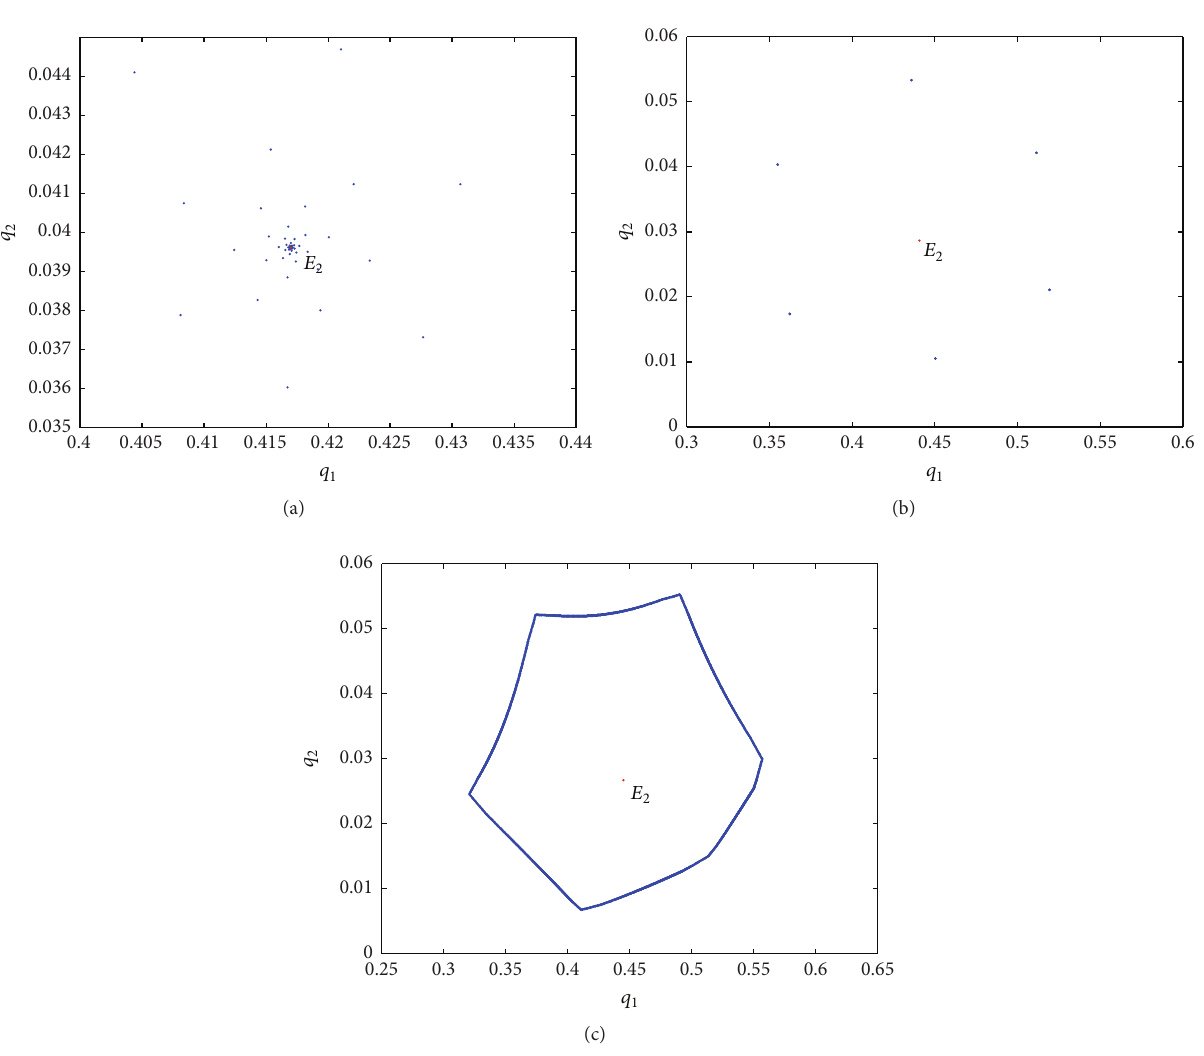
= 0.5, V = 0.5, 𝑐 = 0.12, 𝑐 = 2 1 2 1 2